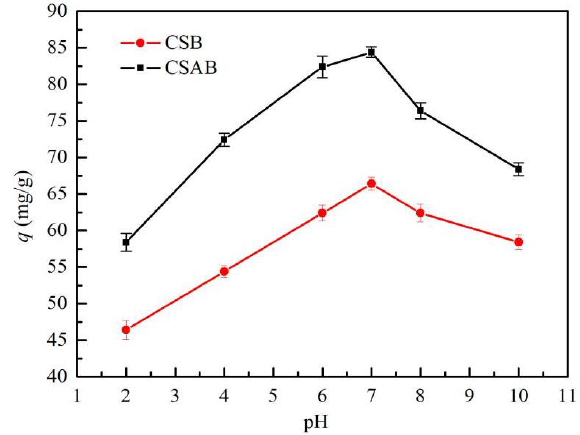
Figure 6. Effect of solution pH on adsorption of diesel oil onto biochar.